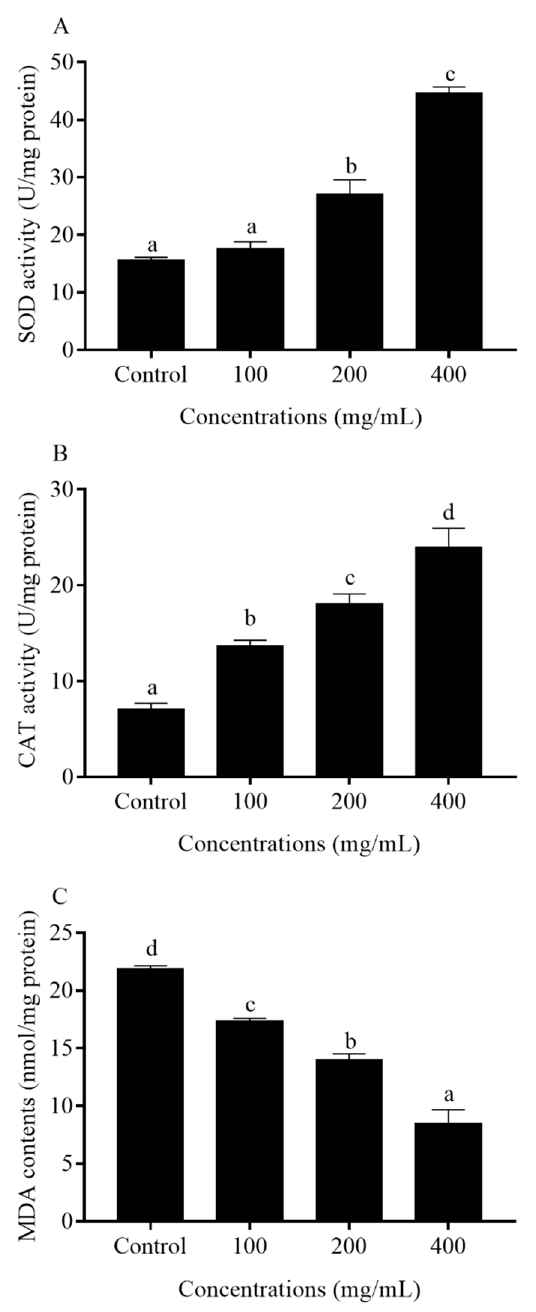
Figure 8. Effect of orange extracts on antioxidant enzymes and MDA contents in C. elegans (mean ± SD, n = 3): ( A ) SOD activity; ( B ) CAT activity; and ( C ) MDA content. Bars with different letters indicate statistical significance ( p < 0.05 , mean ± SD, n = 3).